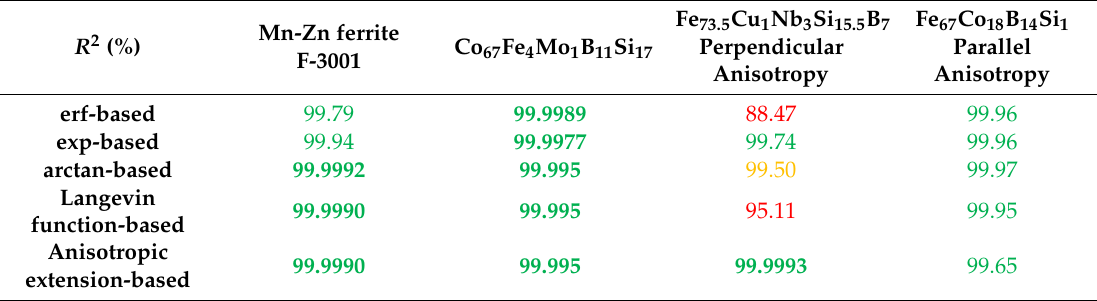
Table 6. General assessment of model’s accuracy quantified by R 2 parameter expressed in percentages (Green—good, orange—poor, red—very